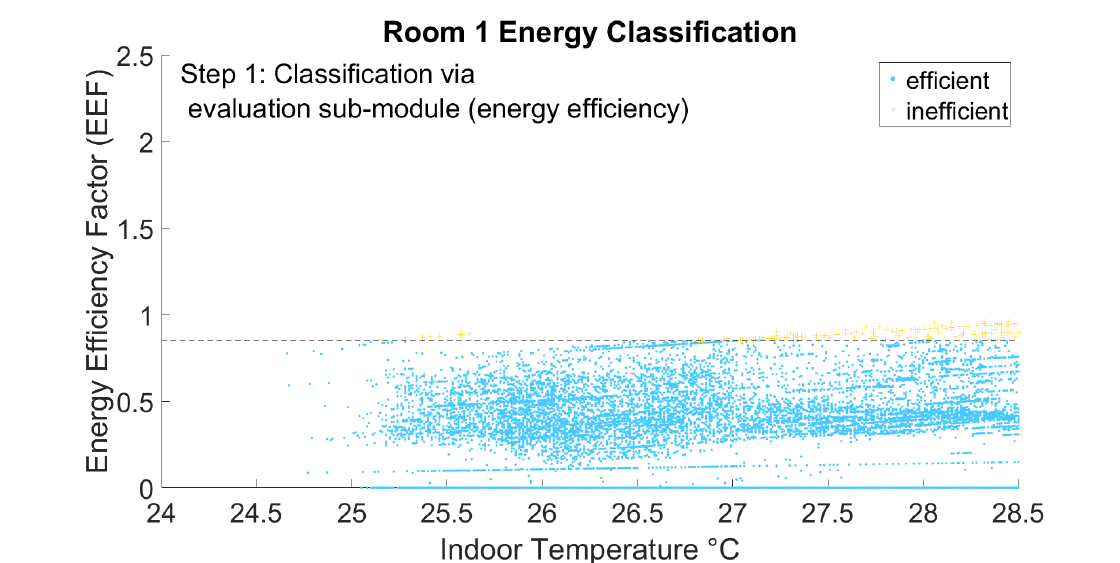
Figure 3. Classification of energy-efficient and energy-inefficient behavior based on inference rules in the evaluation sub-module for